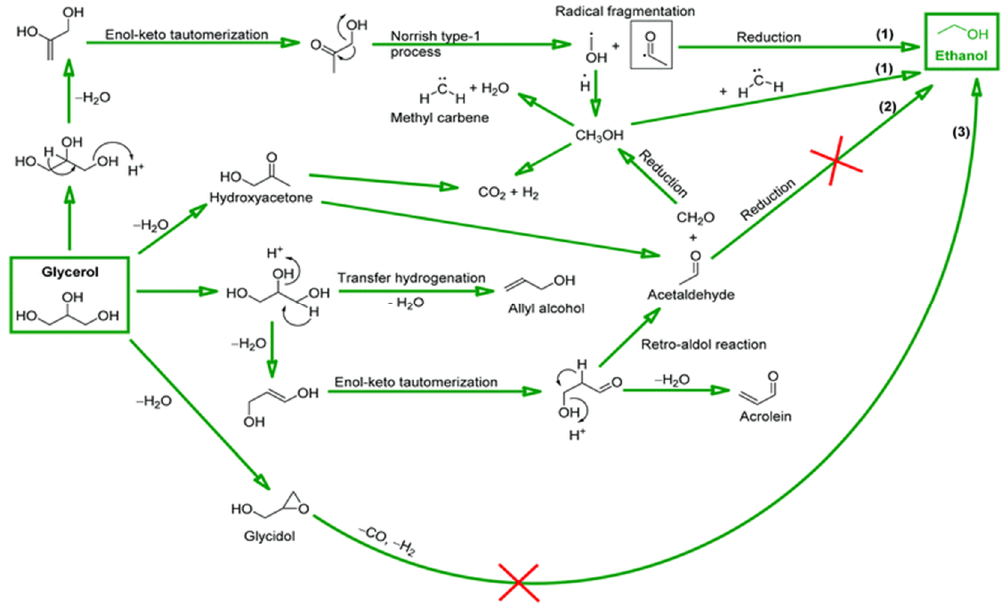
Figure 4. The reactor configuration used for the synthesis of methanol from glycerol. The process is separated into two distinct catalysed reactions: (i) Glycerol reforming to produce syngas and (ii) methanol synthesis. Reproduced from ref. [63] with permission from Elsevier.